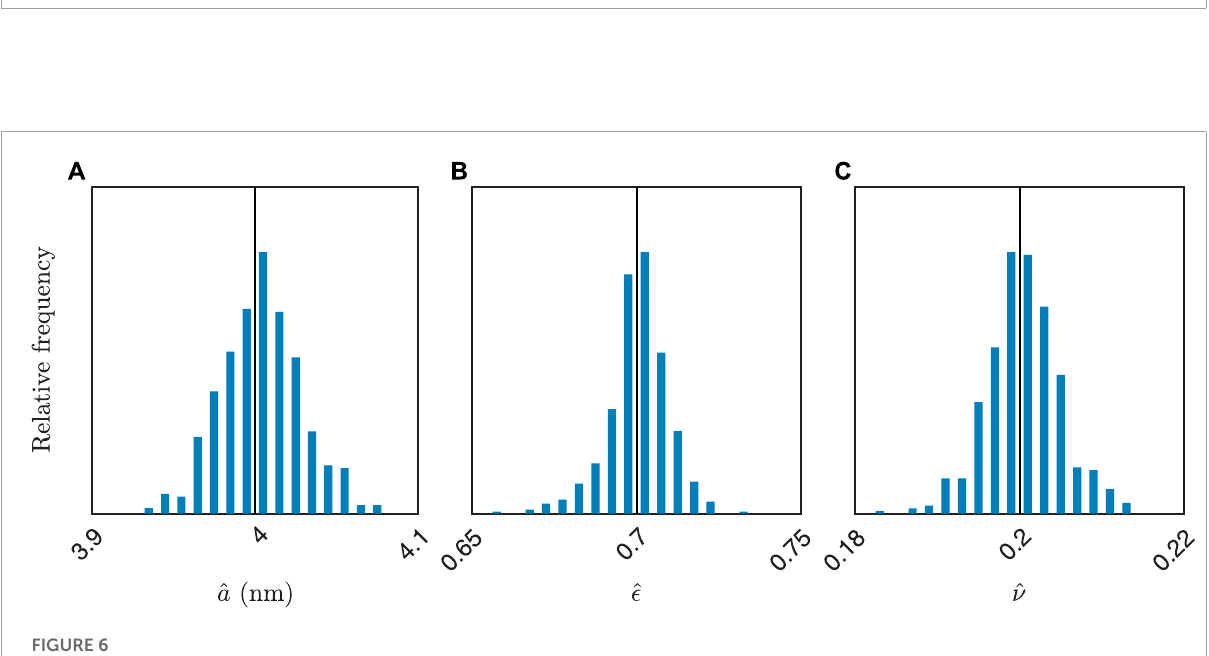
FIGURE 5 Scatter plots showing prediction results on the test set for both three-phase datasets. In (A–C) , predictions of a , ϵ , and ν are shown for the three-phase low porosity structures. In (D–F) , predictions of a , ϵ , and ν are shown for the three-phase high porosity structures.